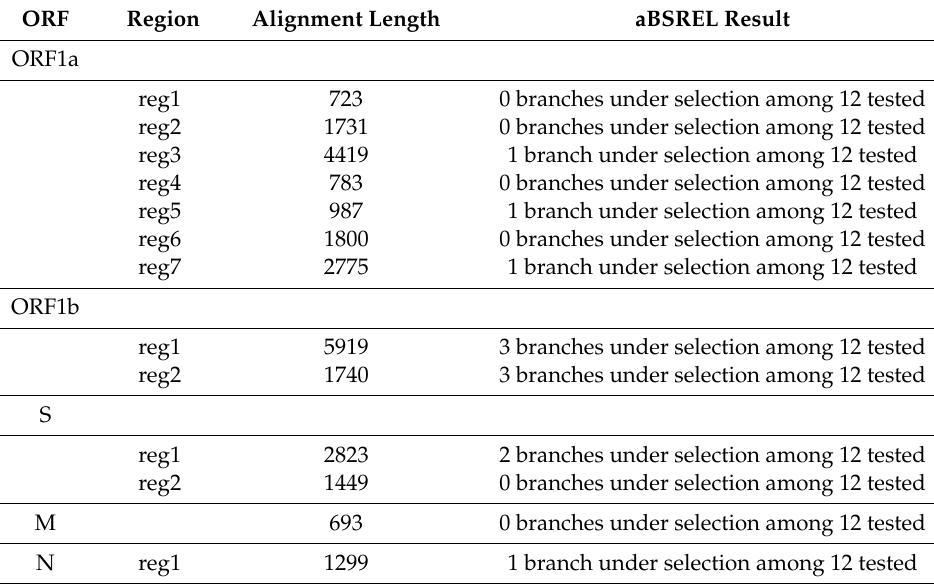
Table 3. Analysis of episodic diversifying selection in embecovirus